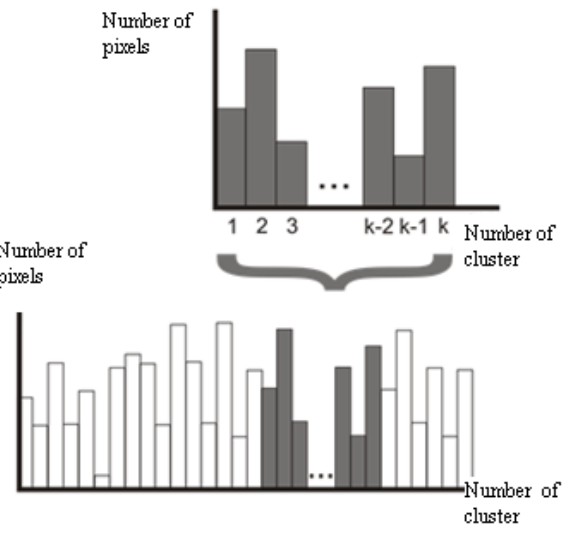
Figure.4. Concatenating the